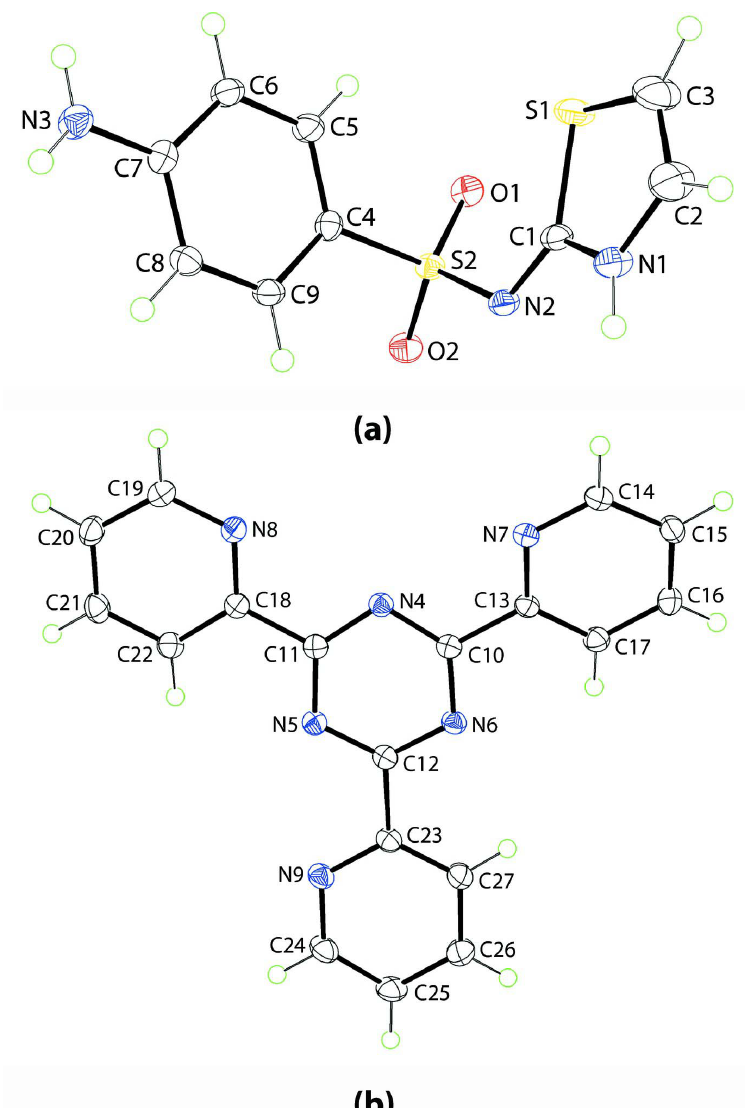
Figure 1 Molecular structures of ( a ) 4-amino- N -(1,3-thiazol-2(3 H )-ylidene)benzenesulfonamide (sulfathiazole), and ( b ) 2,4,6-tris- (pyridin-2-yl)-1,3,5-triazine, showing atom-labelling scheme and displacement ellipsoids at the 50% probability